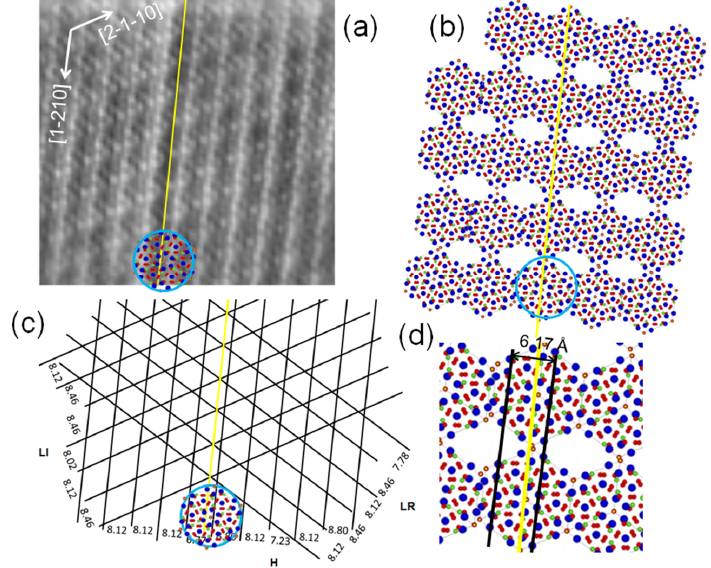
Figure 6. ( a ) STEM-HAADF image of human tooth enamel crystals in the [0001] direction. ( b ) Ar- rangement obtained by identifying the bright points with the Ca atoms of HAP. The voids are presented just for the clarity of the arrangement. Note the superposition of the atoms positions. ( c ) Periodicities observed along the H, LI, and LR lines separately. ( d ) Magnification of the CDL zone; the observed thickness of the CDL is also indicated. The blue circle is at the same position in the three cases. The yellow line indicates the position of the CDL. Ca atoms are in blue, P atoms are in green, O atoms are in red, and H atoms are in yellow.